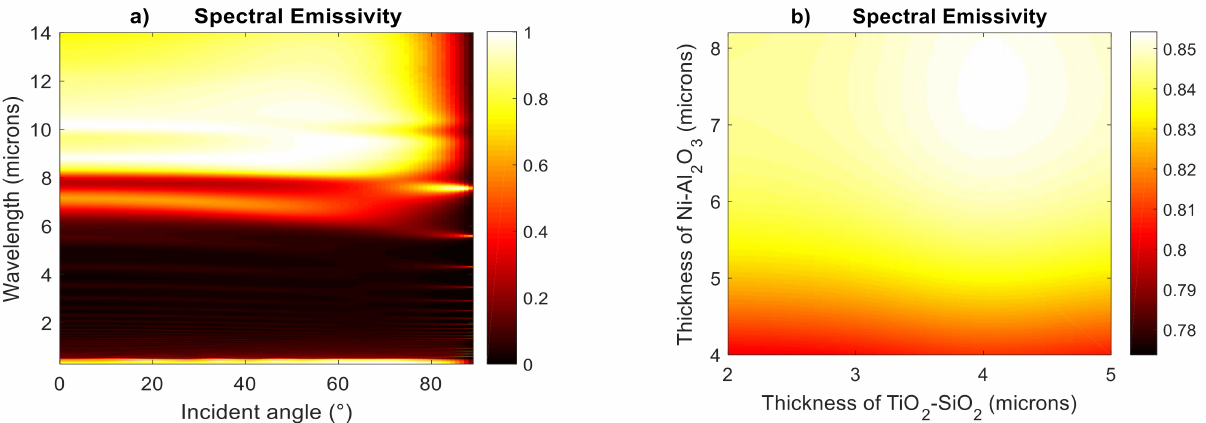
Figure 6. Effect of the incident angle and thickness of each layer on the spectral emissivity: ( a ) spectral averaged emisivity as a function of incident angle and wavelength. ( b ) spectral averaged emissivity for a simple coating selective emitter as a function of